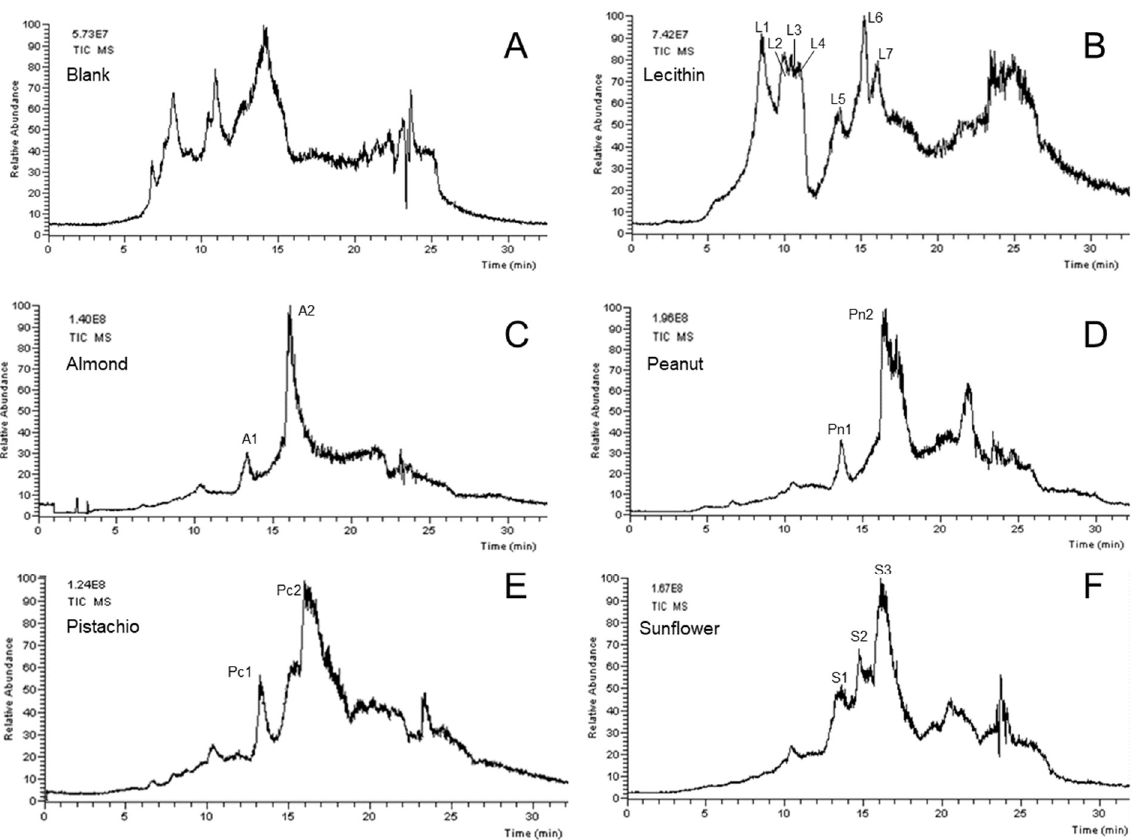
Figure 5. Comparison of the chromatograms obtained from ( A ) blank, ( B ) lecithin standard, ( C ) almond, ( D ) peanut, ( E ) pistachio, and ( F ) sunflower. Quaternary gradient going from 100% of H 2 O (0.1% FA) to 100% of methanol (0.1% FA) in 10 min, followed by a linear gradient to 90% of chloroform and 10% of methanol (0.1% FA) in 10 min, and the last stem of a linear gradient of 90% of 2-propanol and 10% of methanol (0.1% FA) in 10 min, followed for more 5 min of isocratic 90% of 2-propanol and 10% of methanol (0.1% FA) at 30 ◦ C. SiGO-C18ec (100 × 0.5, 5 FPP), at 0.15 mL/min. TIC chromatograms in m/z range of 50 to